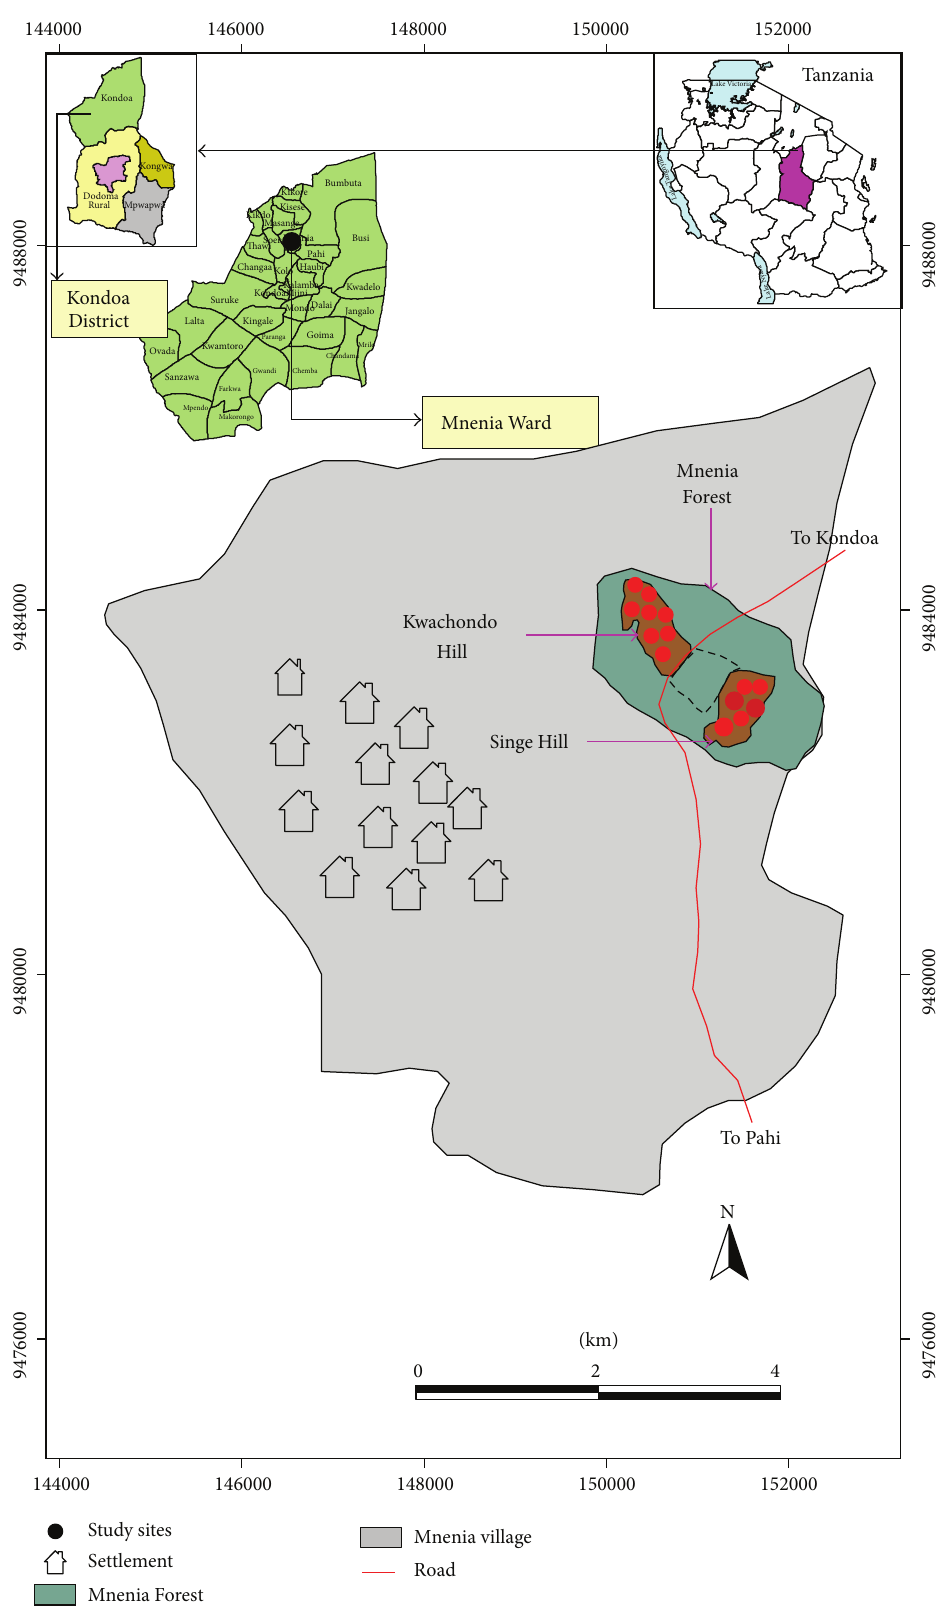
Figure 1: Map of Kondoa district showing the study